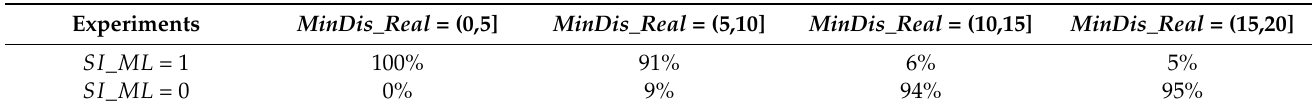
Table 6 makes the same comparison between the classification predictions and the real values of the samples. Table 6. Distribution of the classification predictions and real